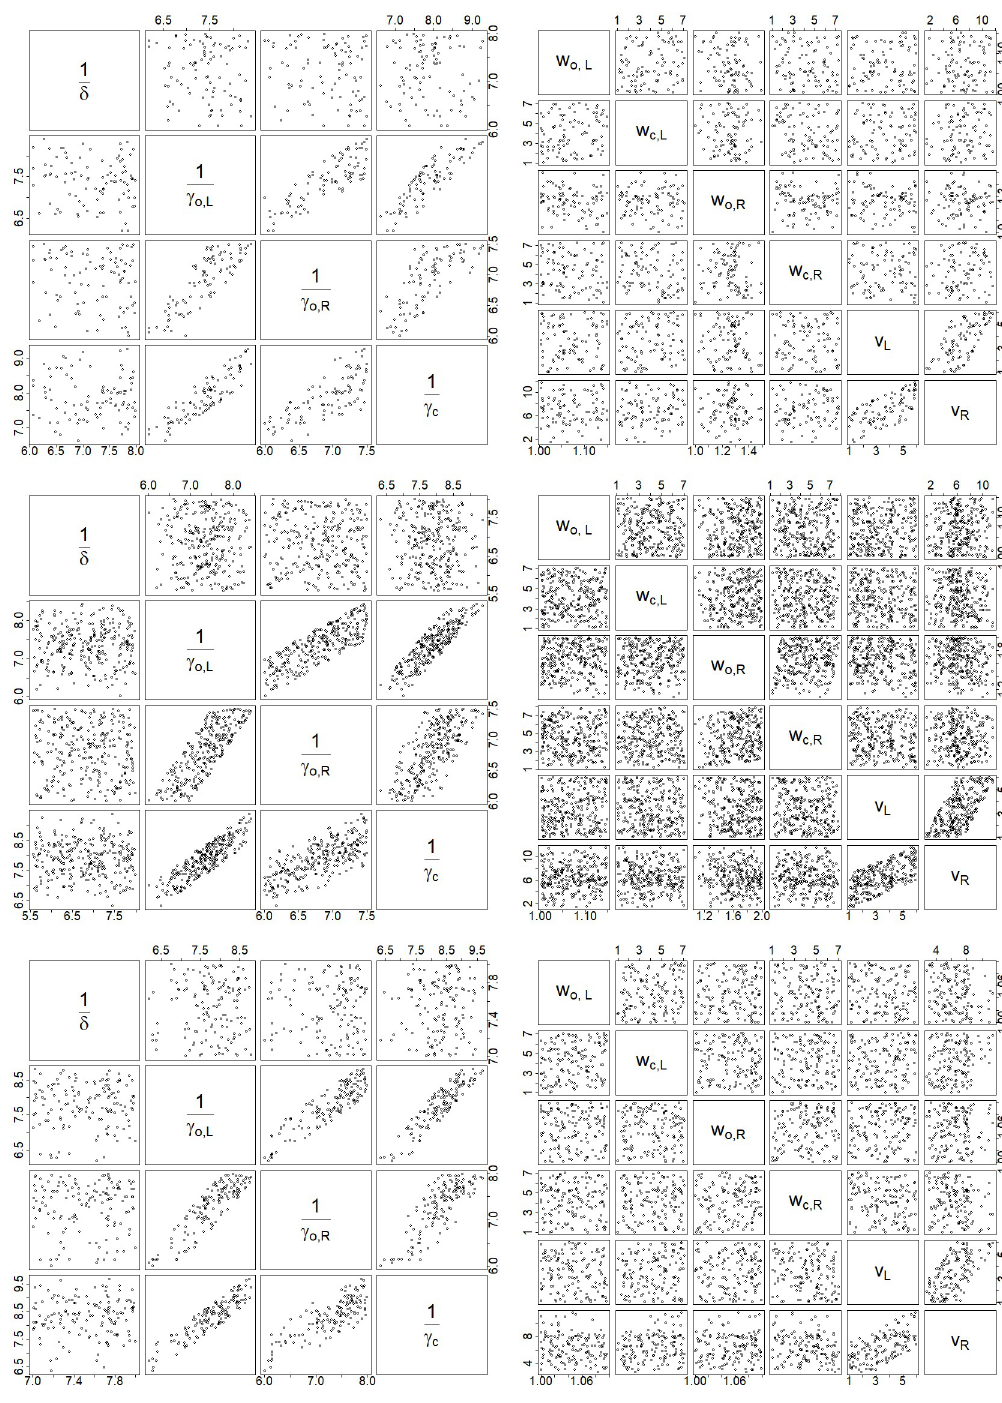
Fig 7. Correlation plots 1. Correlation plots of selected pairs of parameters of the modified SEIR model for Malaysia (top row), Selangor (middle row) and Sarawak (bottom row).